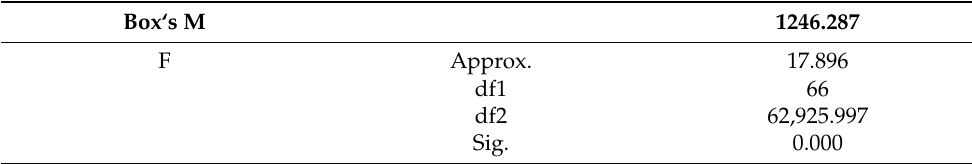
Table 5. Results of Box‘s M